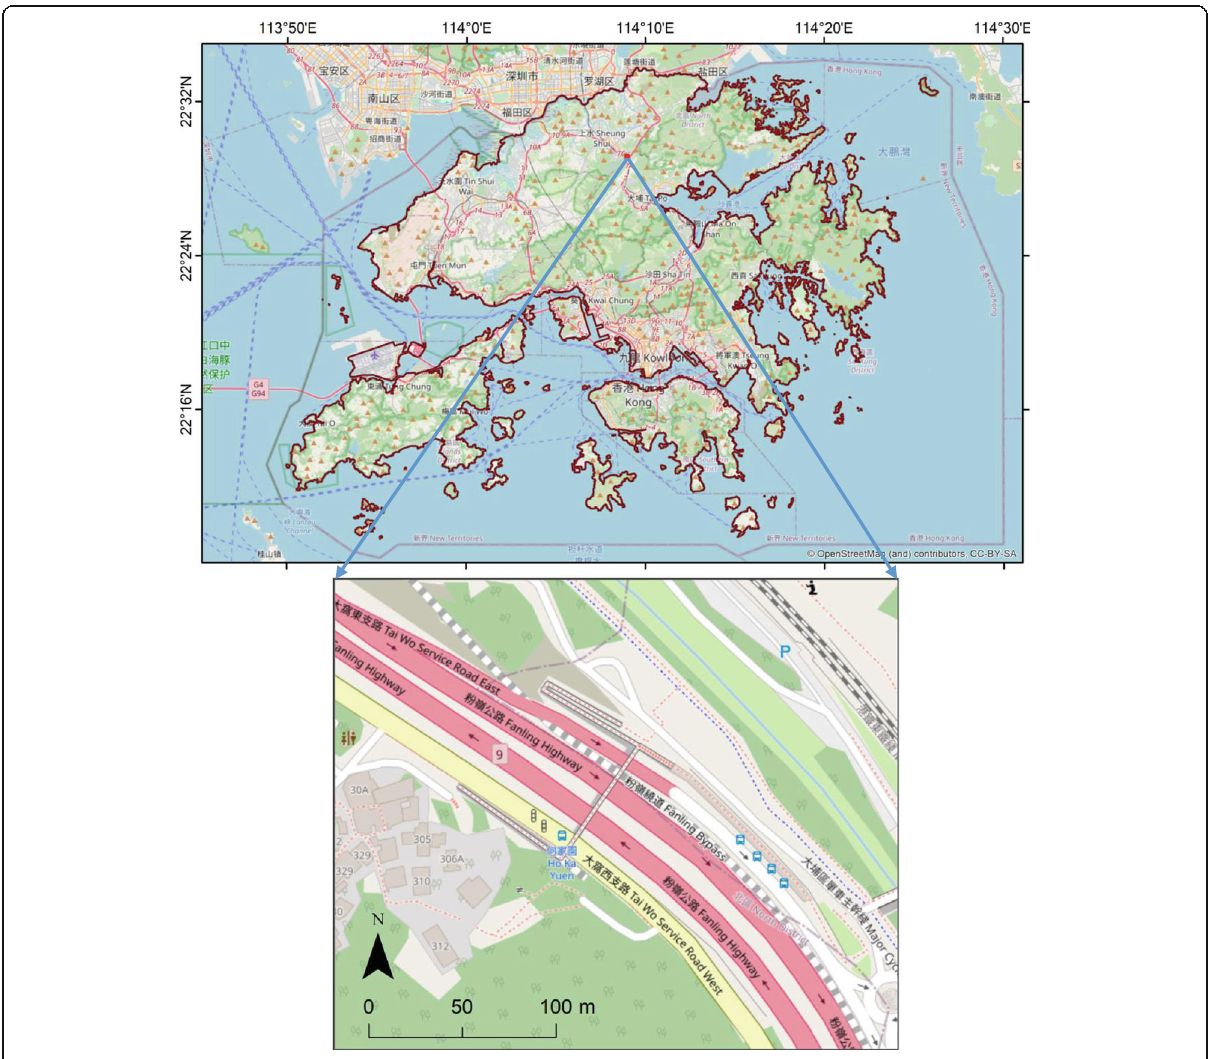
Fig. 1 Location and map of the assumed